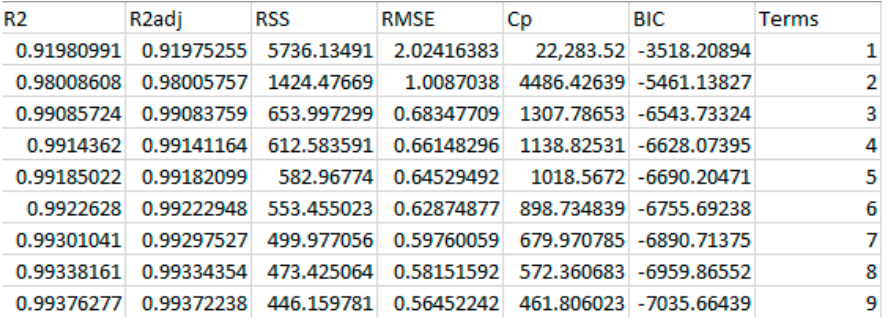
Figure 9. Explained variance depending on number of predictors. As can be seen here, the cut-off is set to the default value of 0.99 . As to be expected, increasing the number of predictors to more than three results is only a slight improve- ment of the adjusted 𝑅 (cid:2870) . Therefore, the number of three or four terms chosen by the ‘best- Model’ method seems to deliver a sufficient norming model, while smoothing the percen- tile curves and cleaning sampling error variance. To investigate possible over- or under- fitting of the model with four predictors, cross validation of the regression model (func- tion ‘cnorm.cv’) can be used: # Cross validation, repeated 10 times with an upper limit of 12 terms cnorm.cv(preparedData, repetitions = 10, max = 12) By using this method, the data set is divided into a training set containing 80% of the complete sample and a validation sample with 20% of the norming sample. Subsequently,